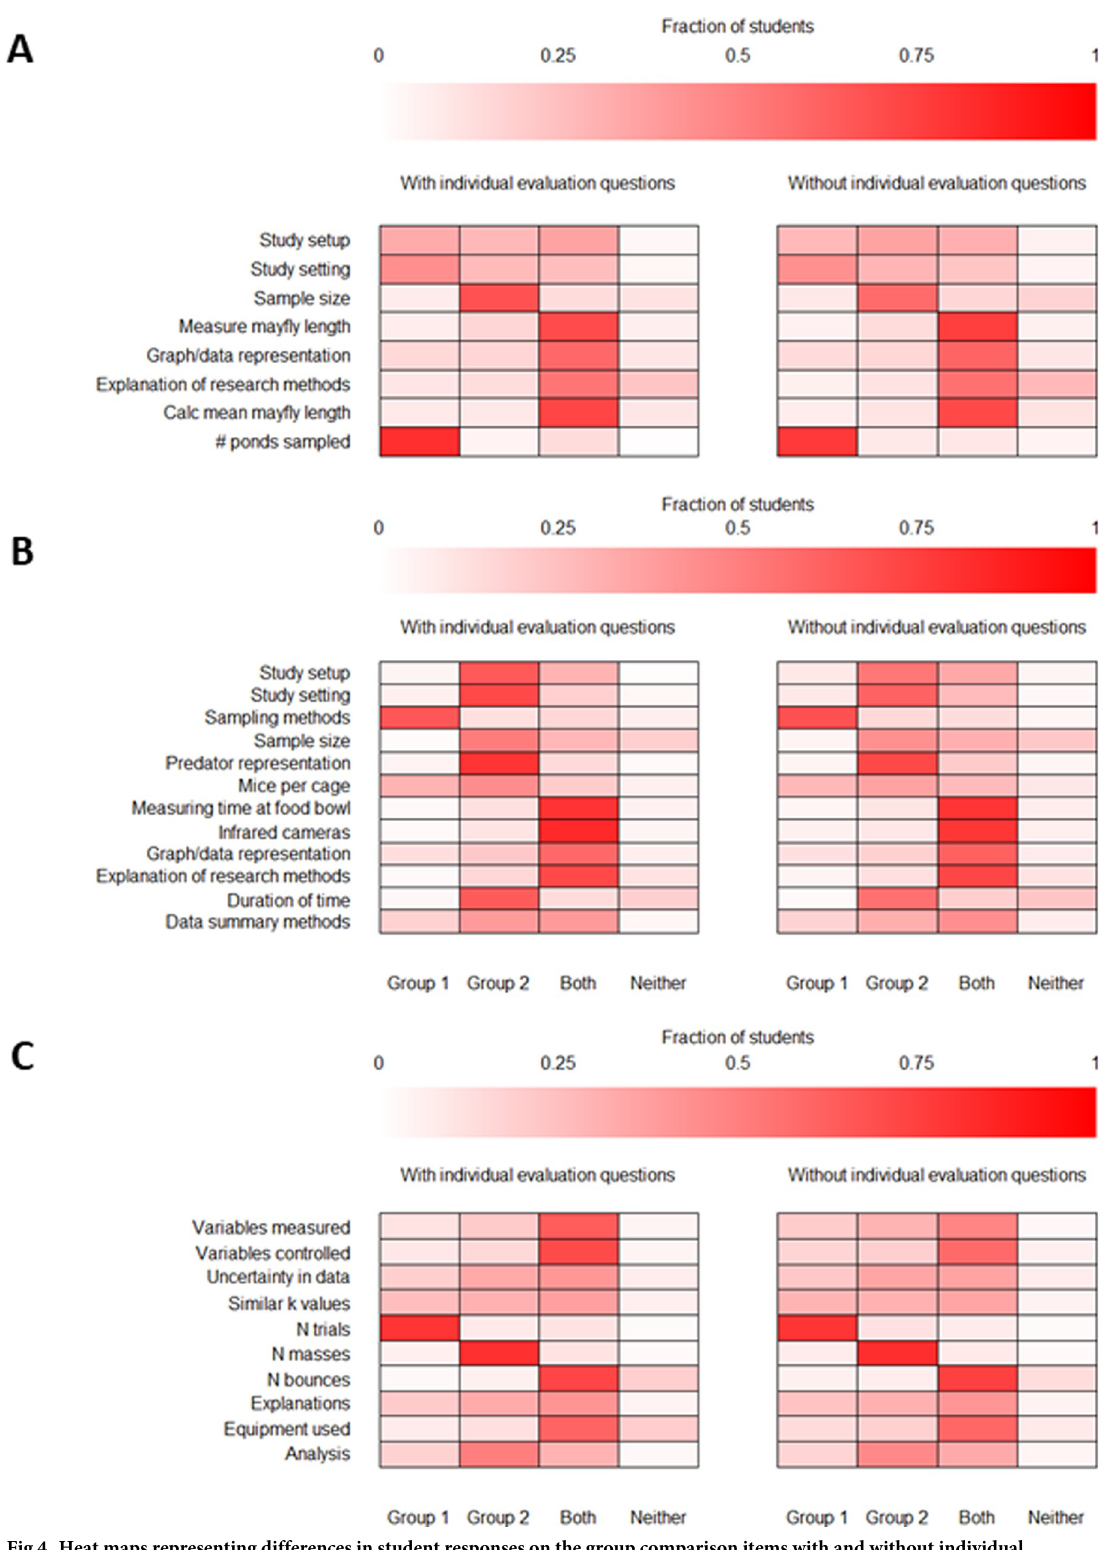
Fig 4. Heat maps representing differences in student responses on the group comparison items with and without individual evaluation questions. The x-axis denotes students’ responses on the group comparison items (i.e., whether they ranked Group 1 as